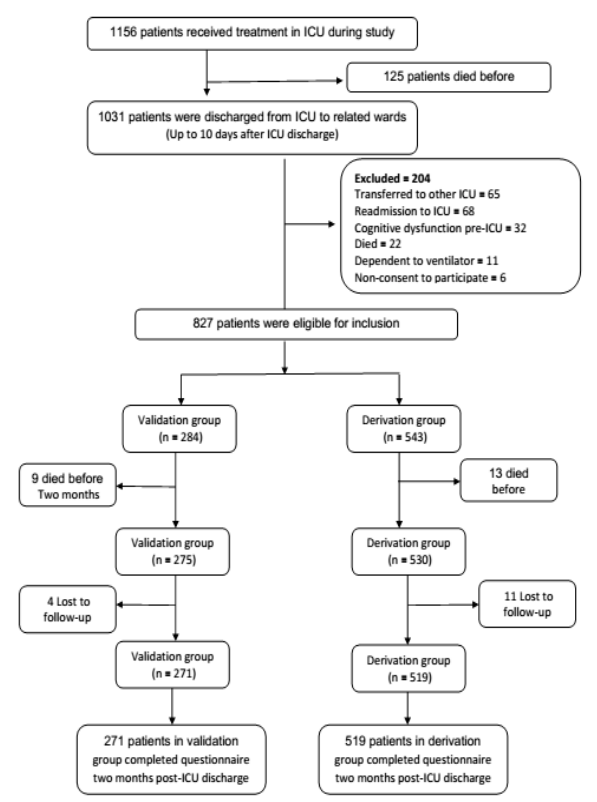
Figure 1. Flow diagram for patients who were included and excluded from the study. ICU: intensive care The status of patients was compared with their status before ICU admission based on ADL score two months after discharge from ICU. Based on this comparison, patients were divided into two groups; the patients who got worse (the Katz ADL index score was lower than the one before admission to the ICU, which indicated that they were more dependent) and patients without changes (whose Katz ADL index score was unchanged from the one before ICU admission). The results showed that the 347 (43.9%) patients had no changes and 443 (56.1%) patients were getting worse. Table 3 shows the distribution of three predictor variables “education level”, “having a fracture”, and “inability to sit with- out support” according to binary ADL staircases in derivation group. Table 3. Three predictor variables “education level”, “having a fracture”, and “inability to sit with- out support” according to binary ADL staircases in derivation group. Variables